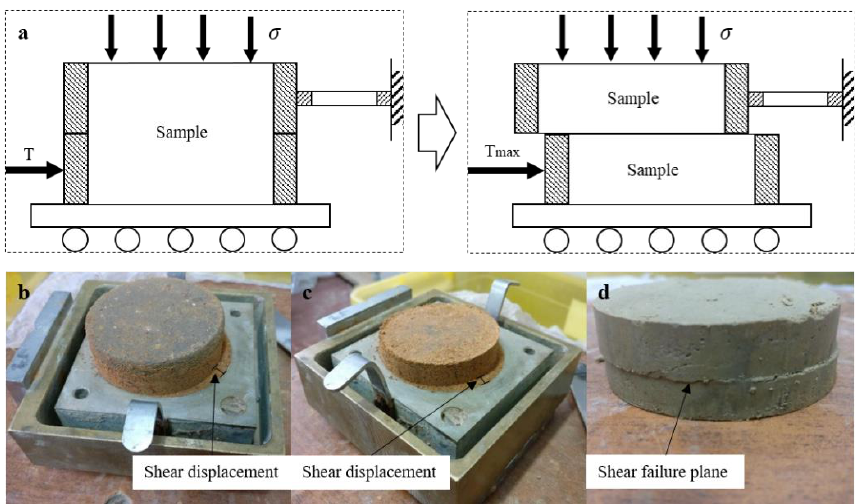
Figure 2. Direct shear test. ( a ) Schematic diagram of the direct shear test. ( b ) Ten percent grouting silty clay. ( c ) Silty clay without grouting. ( d ) Muddy clay without